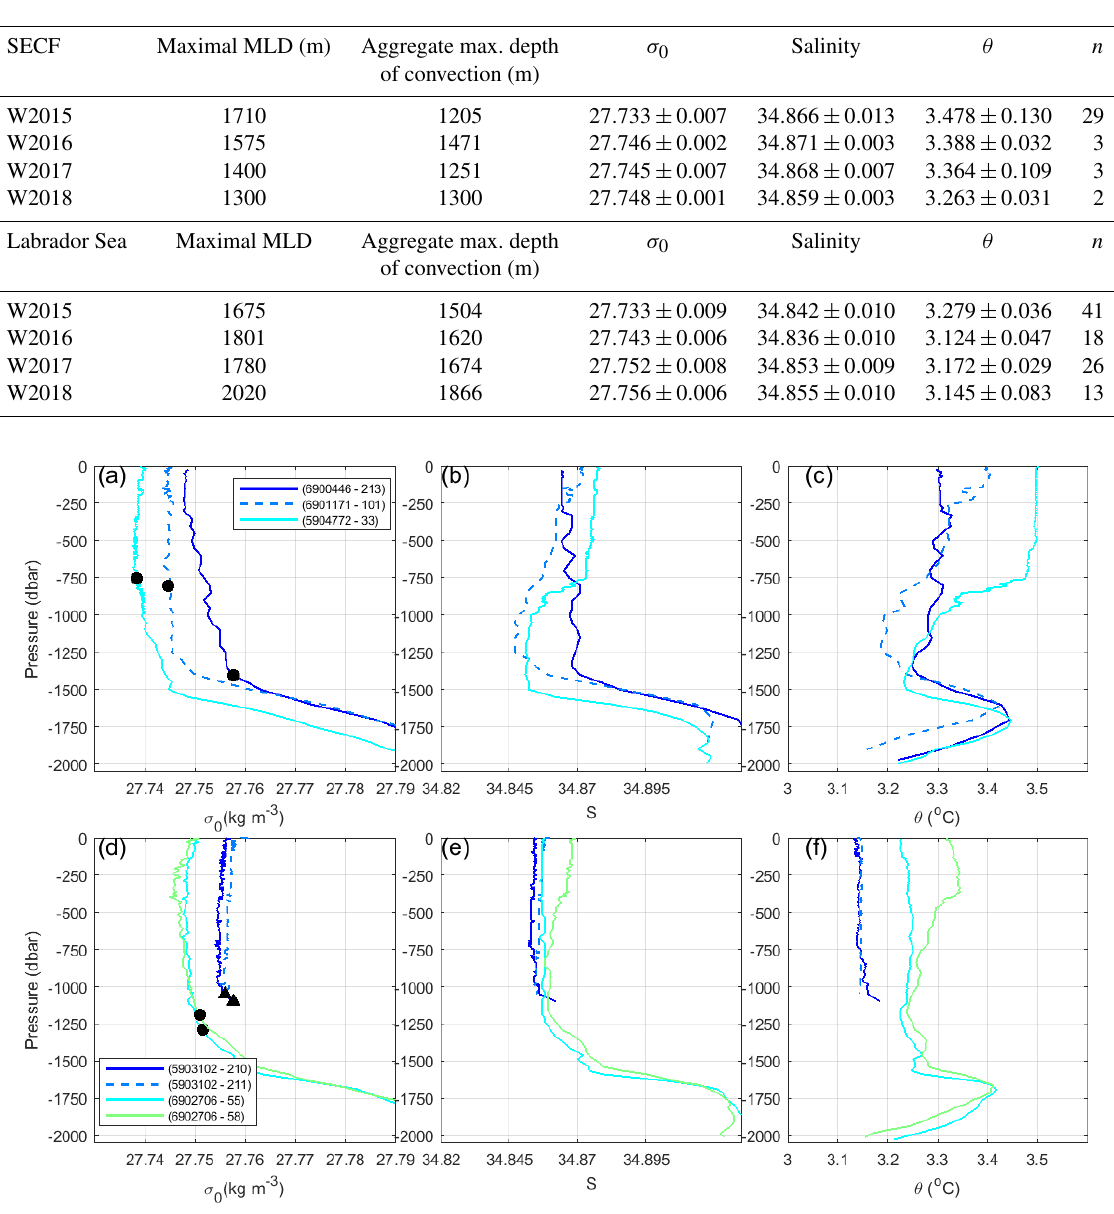
Table 1. Properties of the deep convection SECF and in the Labrador Sea in winters 2015–2018. We show: the maximal MLD observed, the aggregate maximum depth of convection, the σ 0 , S and θ of the winter mixed layer formed during the convection event and n , which is the number of Argo profiles indicating deep convection. The uncertainties given with σ 0 , S and θ are the standard deviation of the n values considered to estimate the mean values.